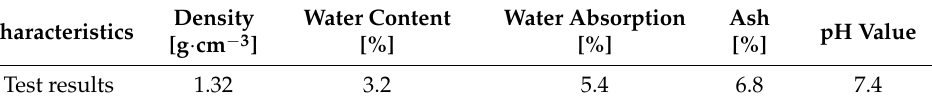
Table 1. Technical indices of corn straw fiber.